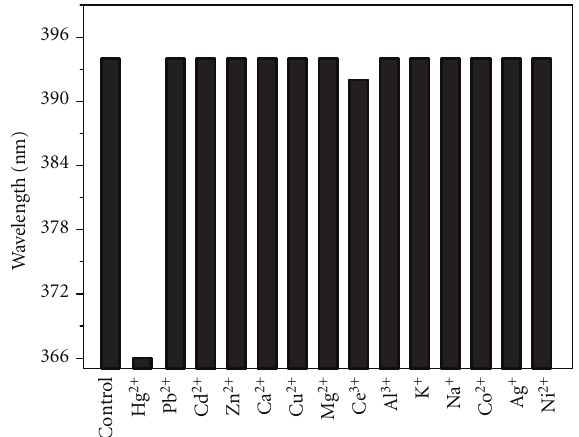
Figure 5: Selectivity of the reactive system. Concentration: AgNPs: 6.5 × 10 − 5 mol/L; Hg (II) ion: 6.0 × 10 − 6 mol/L; the other metal ions: 6.7 × 10 − 6 mol/L; HAc-NaAc bu ff er (pH 5.6).